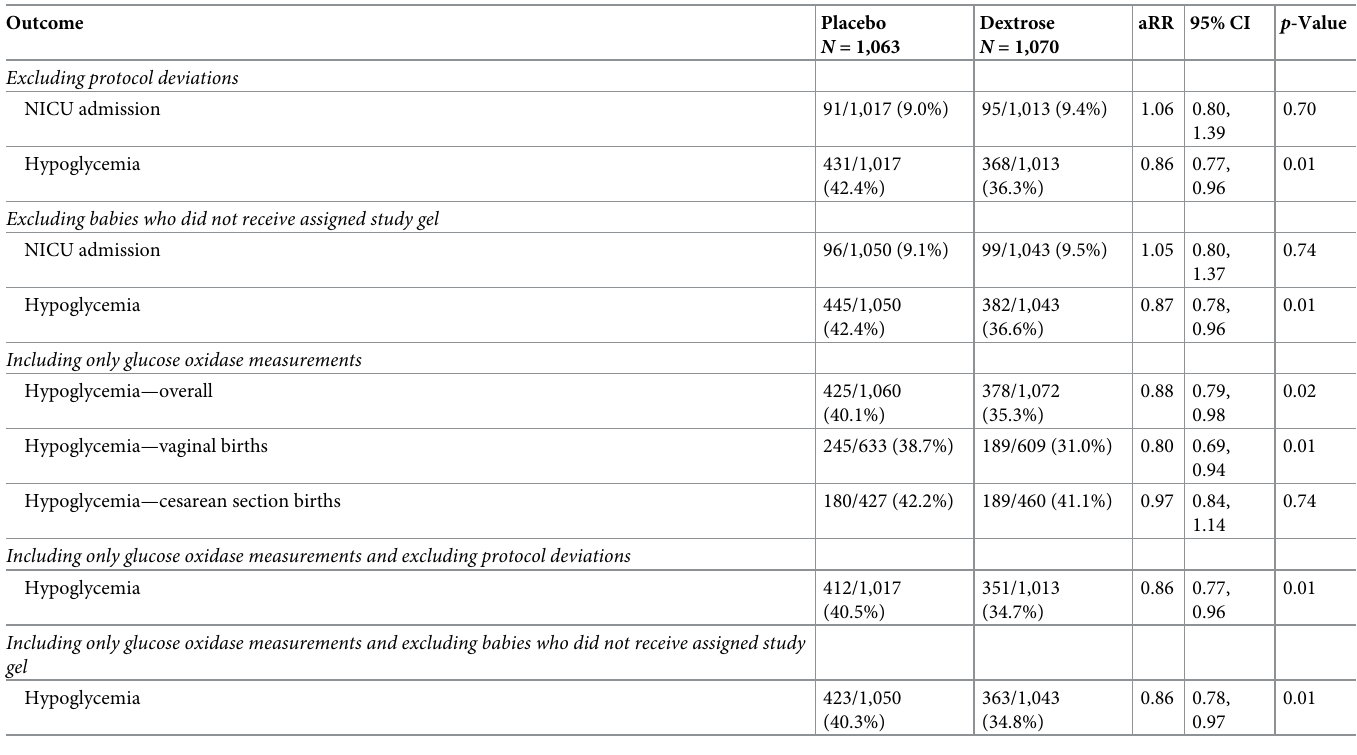
Table 3. Prespecified sensitivity